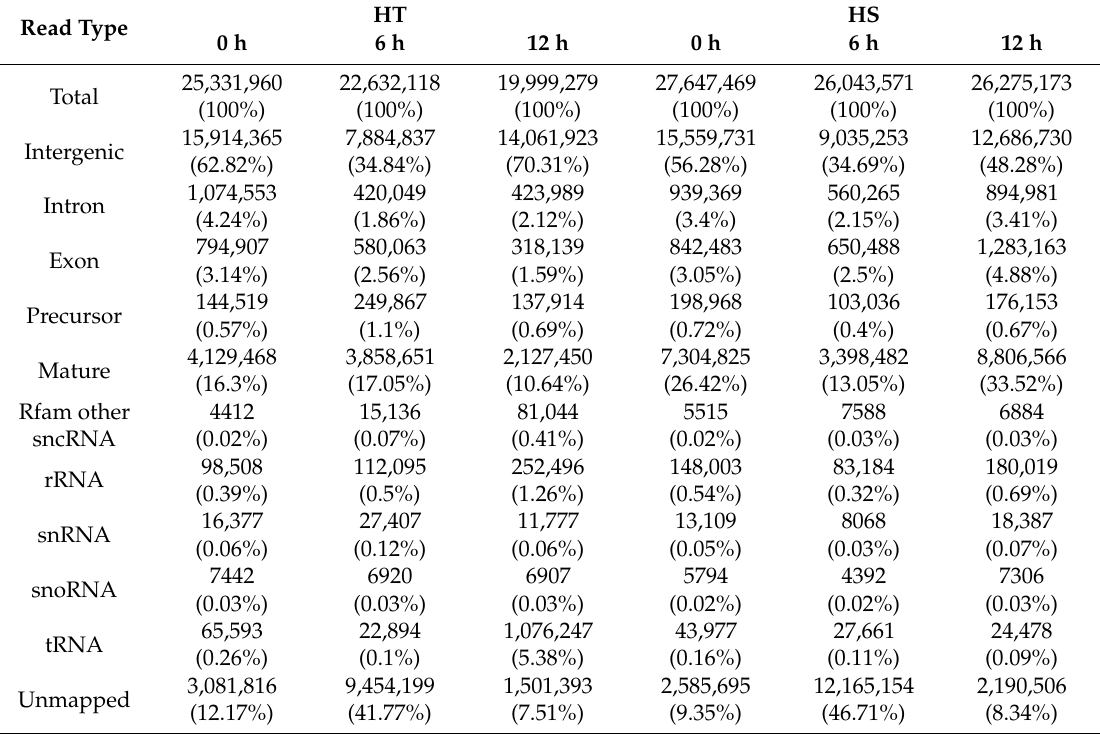
Figure 1. Sequence read length distribution of the small RNAs (sRNAs) from the heat-tolerant (HT) and heat-sensitive (HS) genotypes of flowering Chinese cabbage. Table 1. Classification of heat-responsive small RNAs of heat tolerant (HT) and heat susceptible (HS) genotypes of flowering Chinese